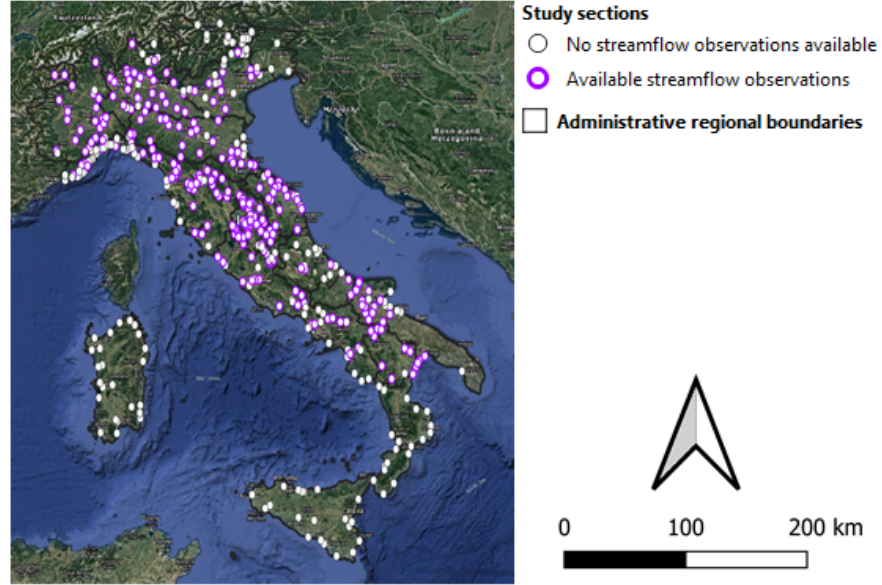
Figure 1. Location of study sections (markers with violet edge are sections with available observed streamflow